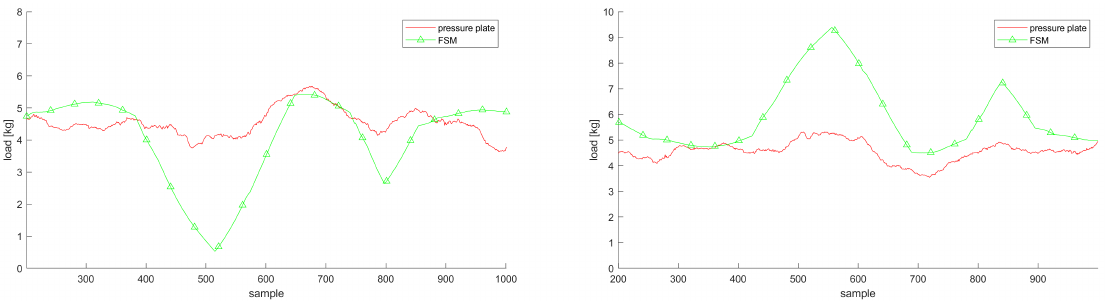
Figure 8. vGRF trajectories for the left and right foot demonstrating the effect of poorly tracked CoM while shifting the weight back and forth; both plots show the estimations and measurements in Newton per